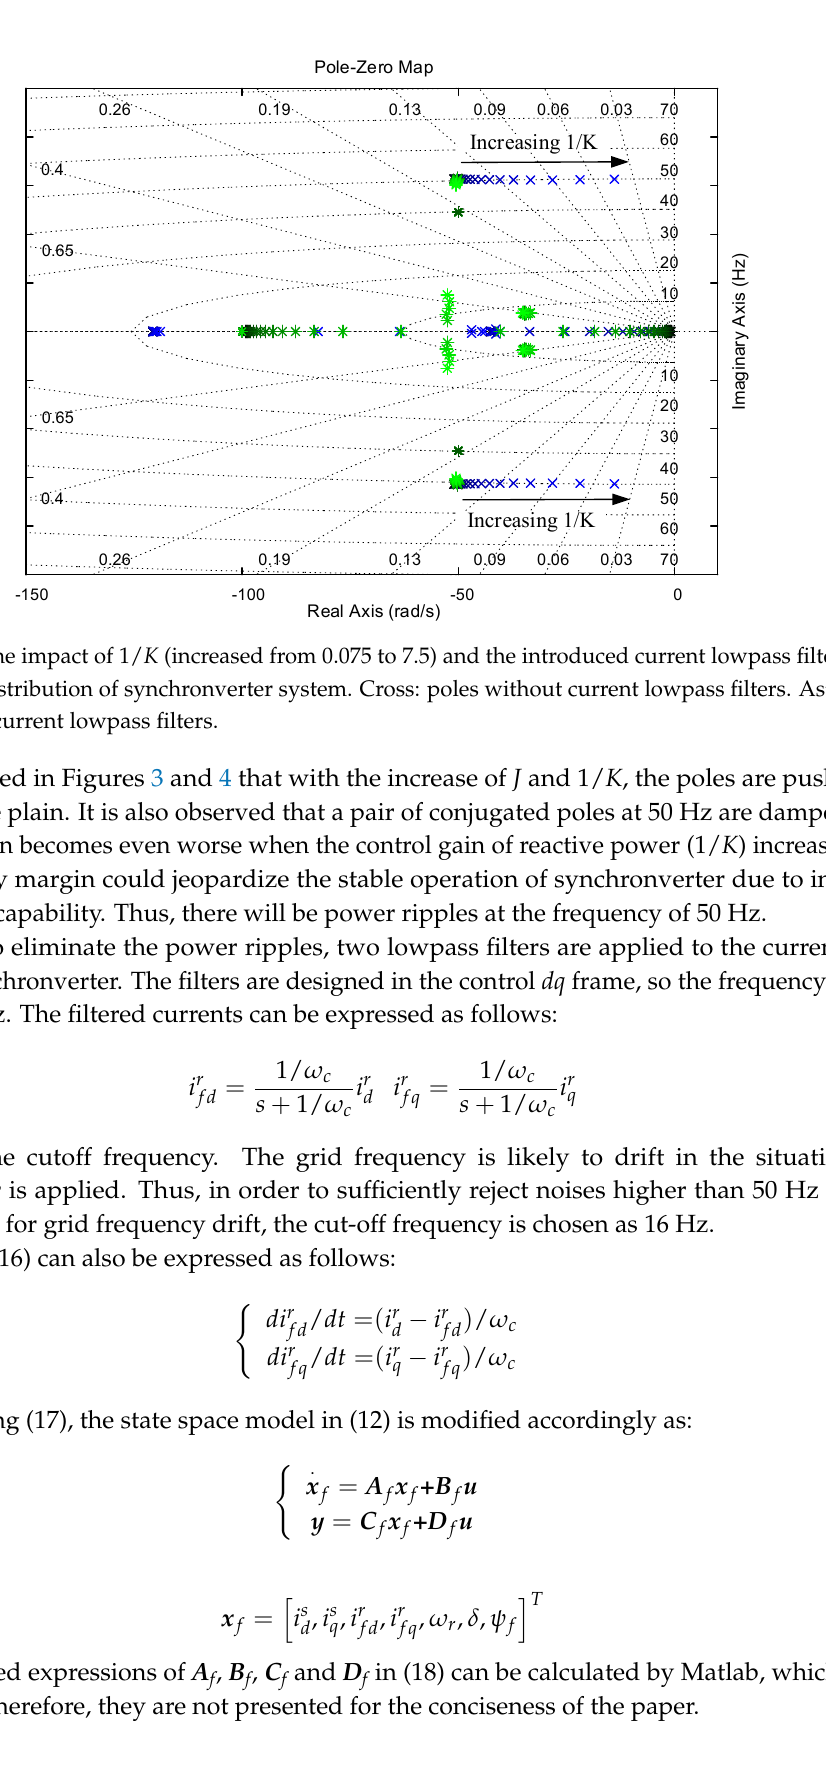
Figure 3. The impact of J (increased from 0.06 to 6) and the introduced current lowpass filters on the poles distribution of synchronverter system. Cross: poles without current lowpass filters. Asterisk: poles with current lowpass filters.